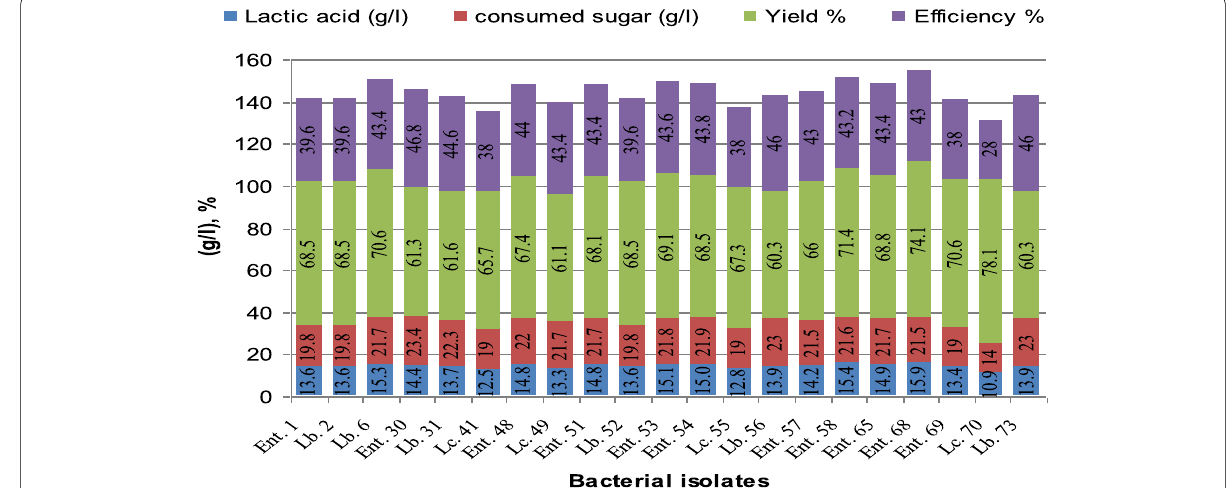
Fig. 1 Production of lactic acid using the best 21 isolates in salted whey (LSD 0.05%